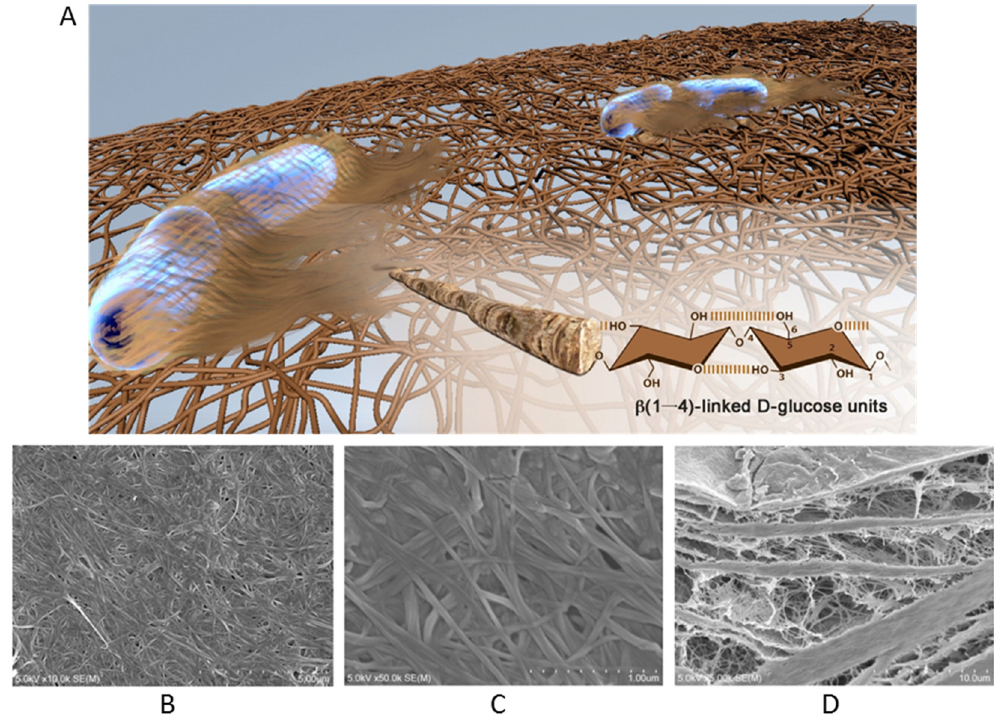
Figure 2. ( A ) A representative model image of a 3D nanofibrous network of BNC as secreted by A. xylinus bacteria (including detailed hydroxyl functional groups of the highlighted single nanofibril). Reproduced with permission from [29]. Copyright 2016 Elsevier. SEM images of BNC surface at different magnifications as ( B ) 10.0 kx and ( C ) 50.0 kx. ( D ) cross-section of BNC (5.0 kx). Reproduced from